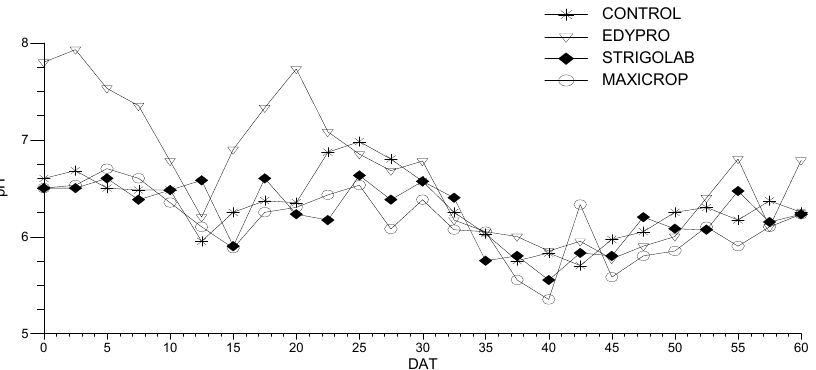
Figure 3. Effects of biostimulant application on pH at the drainage solution.